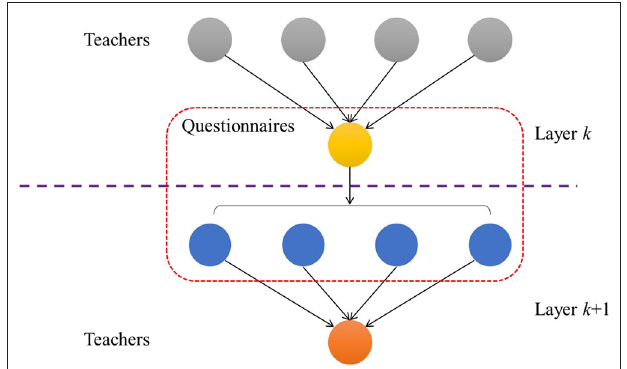
FIGURE 1 | A two-layer graph convolution process.